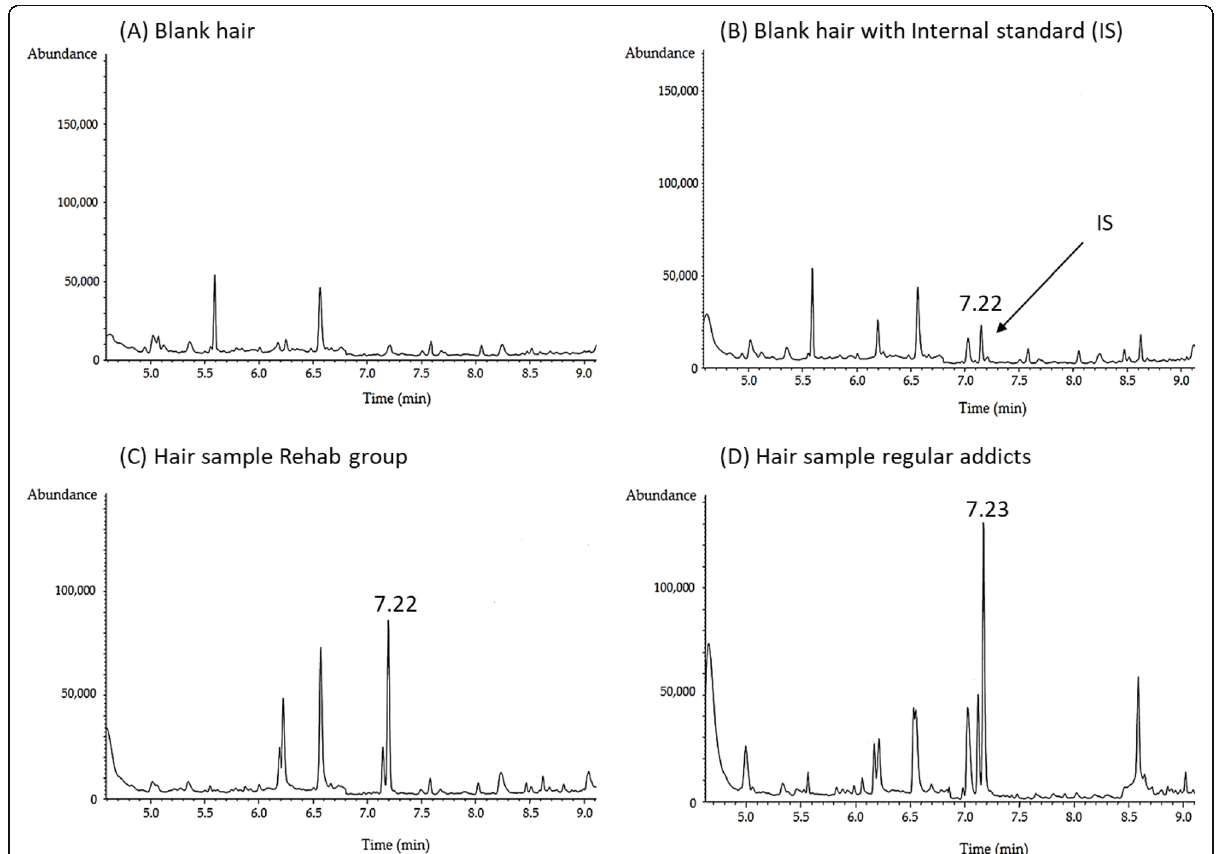
Fig. 3 Representative GC – MS chromatograms for the 6-MAM in addicts ’ and rehab groups, blank hair, blank hair with the internal standard, rehab group, and regular addict group ( a – d ). Internal standard shows that a peak at 7.22 min which correspondingly peaks for target metabolite 6- MAM was observed in the rehab group and regular addicts ’ group ( c , d ) indicating the definite presence of 6-MAM at a specified time corresponding to that as in b . However, certain peaks other than for 6-MAM attribute sample